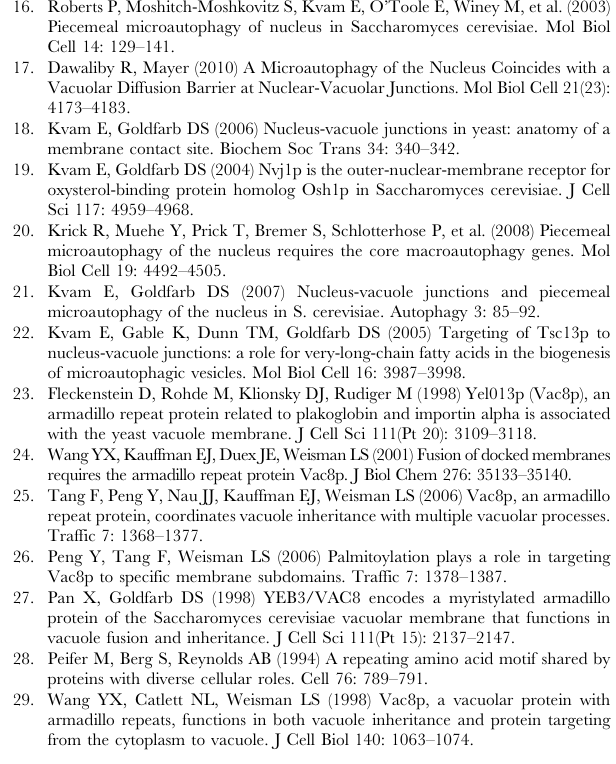
Figure S5 Functional analysis of MoVac8p myristoyla- tion and palmitoylation mutants in caffeine resistance. The MoVAC8:GFP fusion construct and each mutant allele were transformed into the D Movac8 mutant, and three independent transformants for each construct grown on CM plates in the presence of 0.1% caffeine for 15 days. Figure S6 Macroautophagy core gene MoATG1 is nec- essary for vacuole degeneration and ER degeneration during appressorium development in M. oryzae . Left Panels. Degradation of perinuclear and peripheral ER membrane- associated protein, MoTsc13p-GFP, was blocked in D Moatg1 mutants during appressorium development. Right Panels. Degra- dation of vacuolar membrane protein MoVac8p-GFP was blocked in D Moatg1 mutants during appressorium development. Scale bar = 10 m m. Figure S7 MoVAC8 is not required for vegetative growth on different stress medium except caffeine. Uniformly sized mycelial plugs were used to inoculate agar plate cultures supplemented with Congo Red, Calcofluor white (CFW), Sodium dodecyl sulfate (SDS), hydrogen peroxide or caffeine, as shown, and incubated for 12 days at 24 u C.